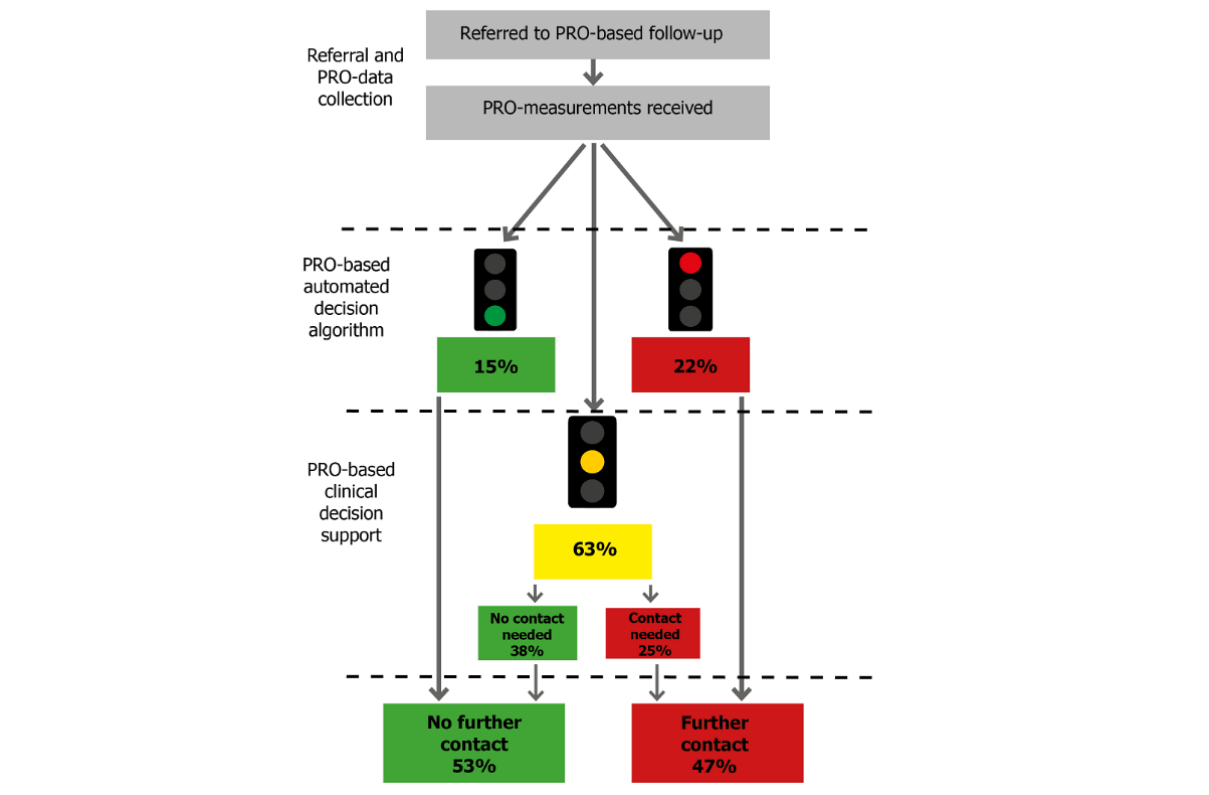
EORTC: European Organization for Research and Treatment of Cancer. Figure 3. Flow chart for outpatients with epilepsy (AmbuFlex). Patients answer the disease-specific questionnaire at fixed intervals (eg, 3 months). In the first step, the answers are processed automatically based on a disease-specific algorithm. Green response: No need or wish for contact (a new questionnaire is scheduled in, eg, 3 months). Yellow response: May need contact (a clinician assesses the PRO overview (Figure 1) and other information to decide whether further contact is needed). Red response: Definite need or wish for contact (the patient is contacted). In total, only 47% of the patients are contacted in each round. PRO: patient-reported